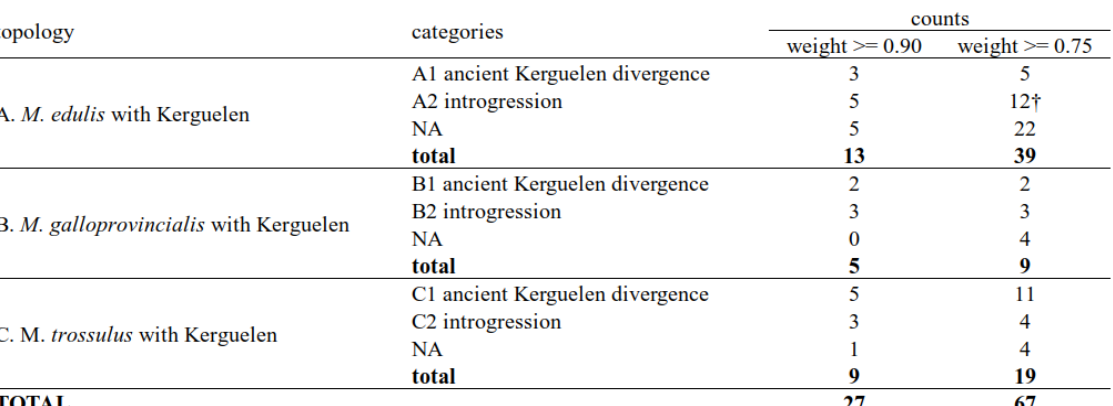
Table 1. Counting the different gene topologies for the GBS